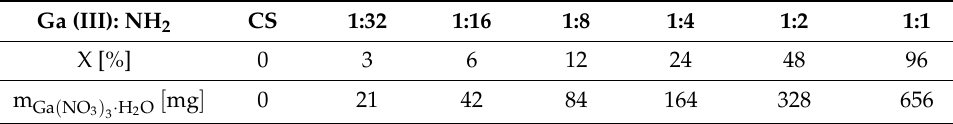
Table 1. Composition of produced Ga (III)-CS